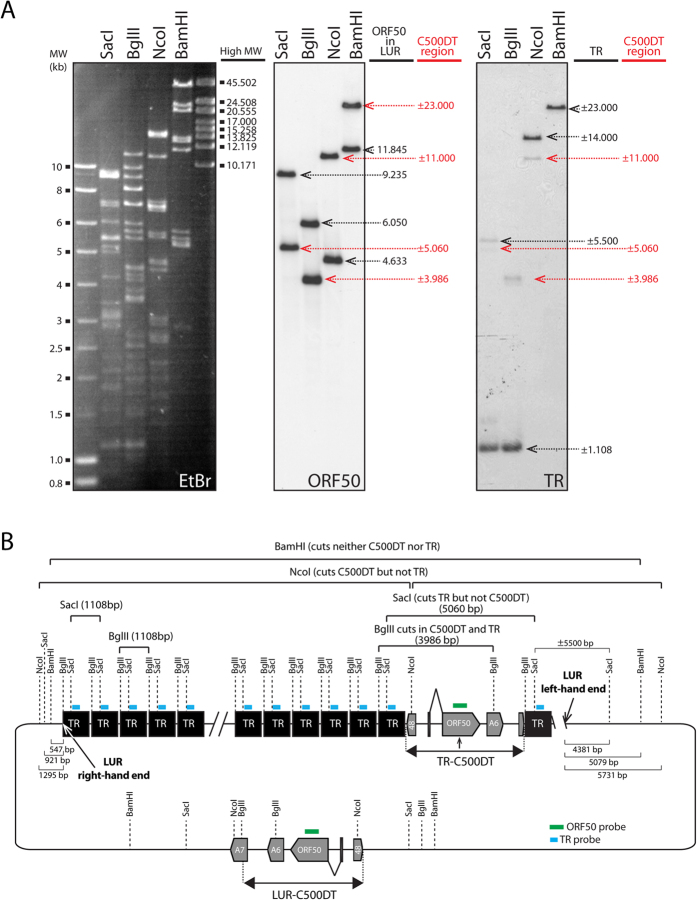
Localization of the duplicated region in the BAC clone by Southern blotting.(A) Southern blot of the BAC clone digested with various restriction endonucleases and hybridized with ORF50 or TR probes. The sizes (anticipated and deduced) of bands from LUR-C500DT or TR-C500DT are shown in black and red, respectively. The ORF50 probe was produced by PCR using primers C500-1 and C500-224. The TR probe was produced after AvrII/SmaI digestion of plasmid pBluescribe-C500RE BS15 and purification of the band corresponding to a 235 bp sequence of TR (nt 490–724 of TR). EtBr indicates ethidium bromide-stained lanes prior to blotting. Entire gels and blots are shown with ladders of medium (MW) and high molecular weight (High MW) standards. (B) Diagram of the BAC clone showing the positions of restriction sites used to locate the duplicated region. Locations of the ORF50 and TR probes used in A are shown by green and blue lines, respectively.